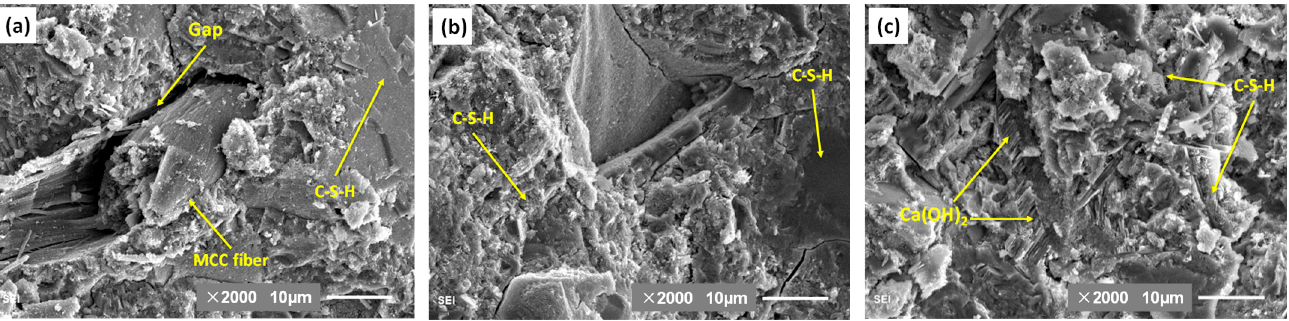
Figure 9. The SEM micrographs of cement paste with ( a ) MCC, ( b ) SMC, and ( c ) control sample at 28 days.